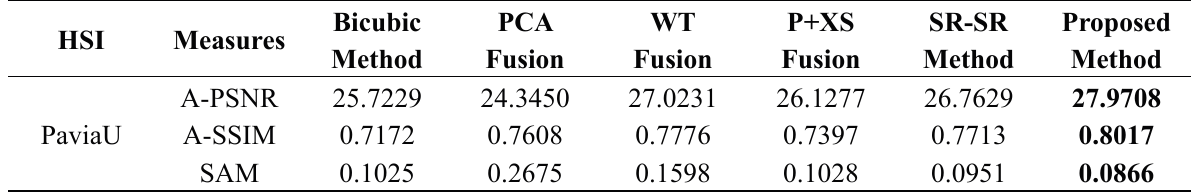
Table 1. Comparison Results of A-PSNR, A-SSIM and SAM of the Different